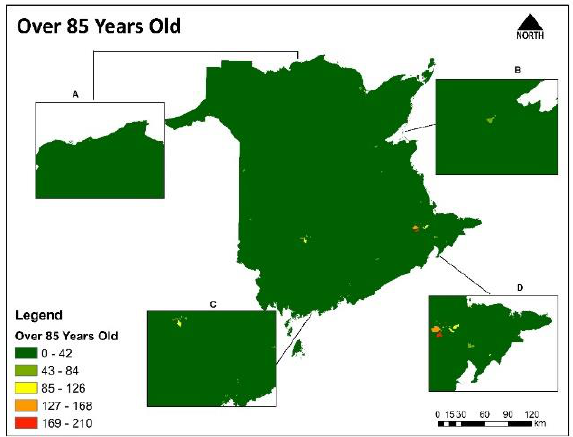
Figure A9. Population Over 85 Years Old.